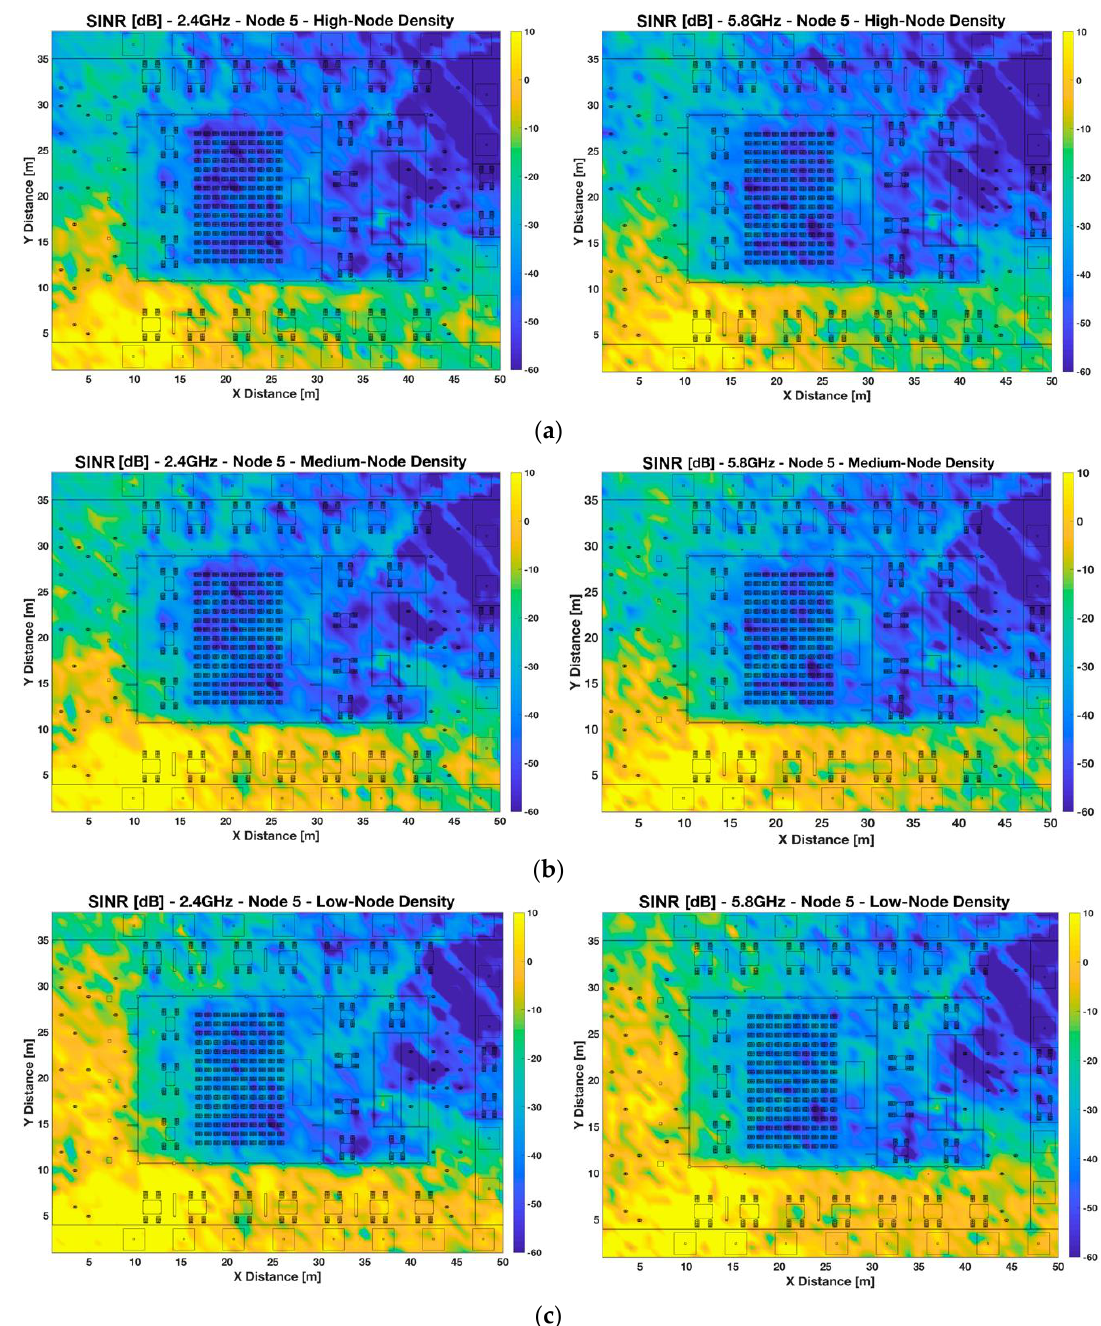
Figure 7. Bi-dimensional planes of SINR [dB] for Node 5 (wearable placed at 1.2 m height, same as a seated person in the outdoor area of the auditorium, X = 11.7 m, Y = 5.8 m) at 2.4 GHz and 5.8 GHz frequency bands. Different scenario setups have been considered: ( a ) high-node density scenario, ( b ) medium-node density scenario, and ( c ) low-node density scenario.